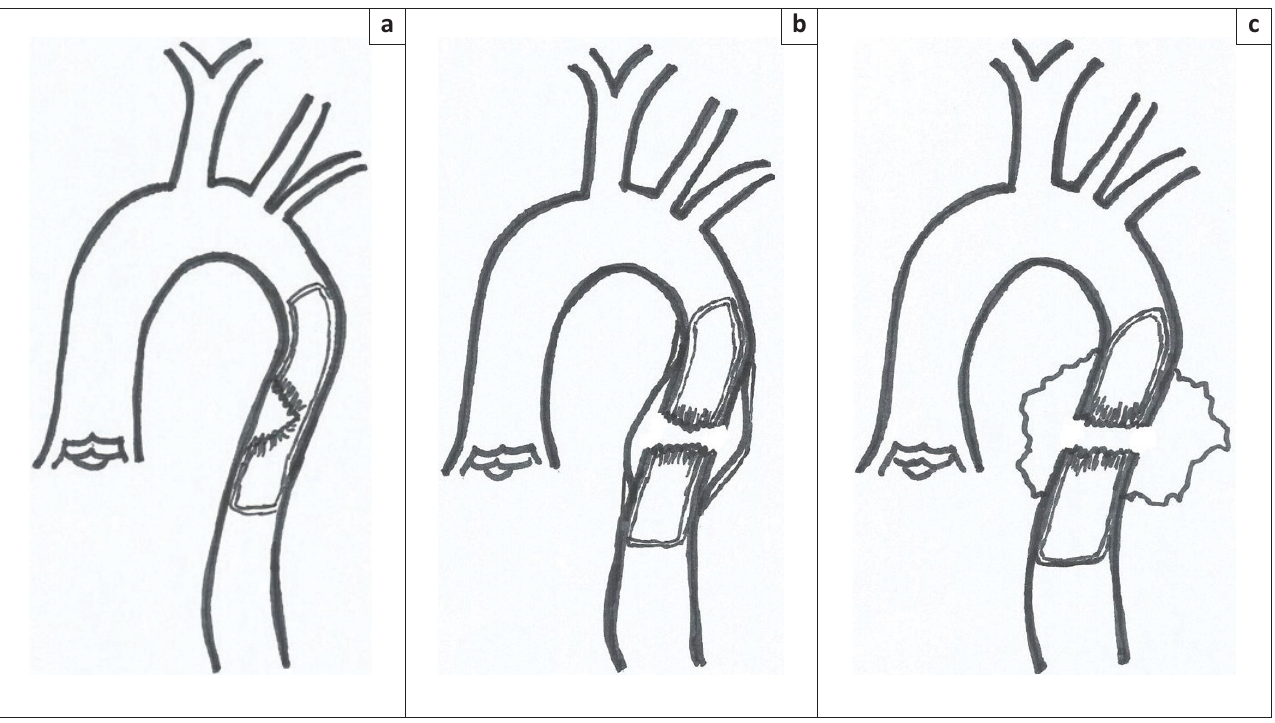
FIGURE 6: Drawing of aortic injury grading findings at computed tomography angiography: (a) Grade 1: isolated intramural haematoma, (b) Grade 2: involvement of the intima and media, and (c) Grade 3: involvement of intima, media and